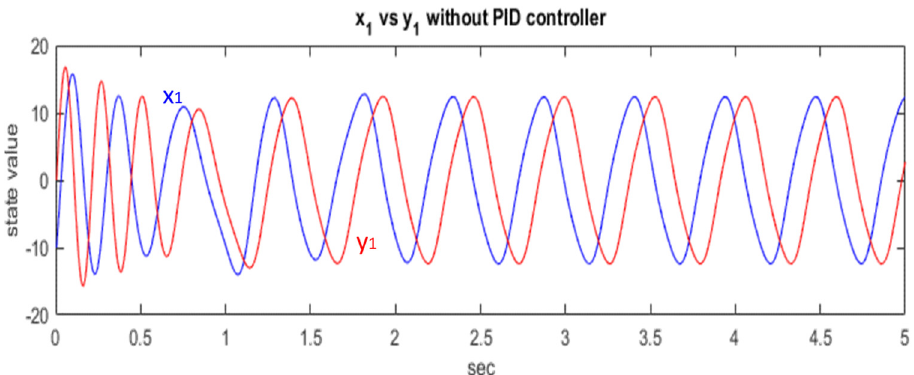
Figure 3. Chaotic systems without PID controller.